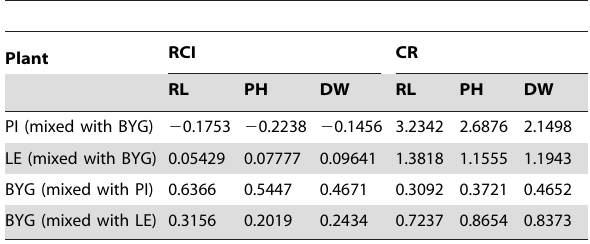
Table 2. Competition indices of rice and barnyardgrass in rice/BYG mixed-cultures.